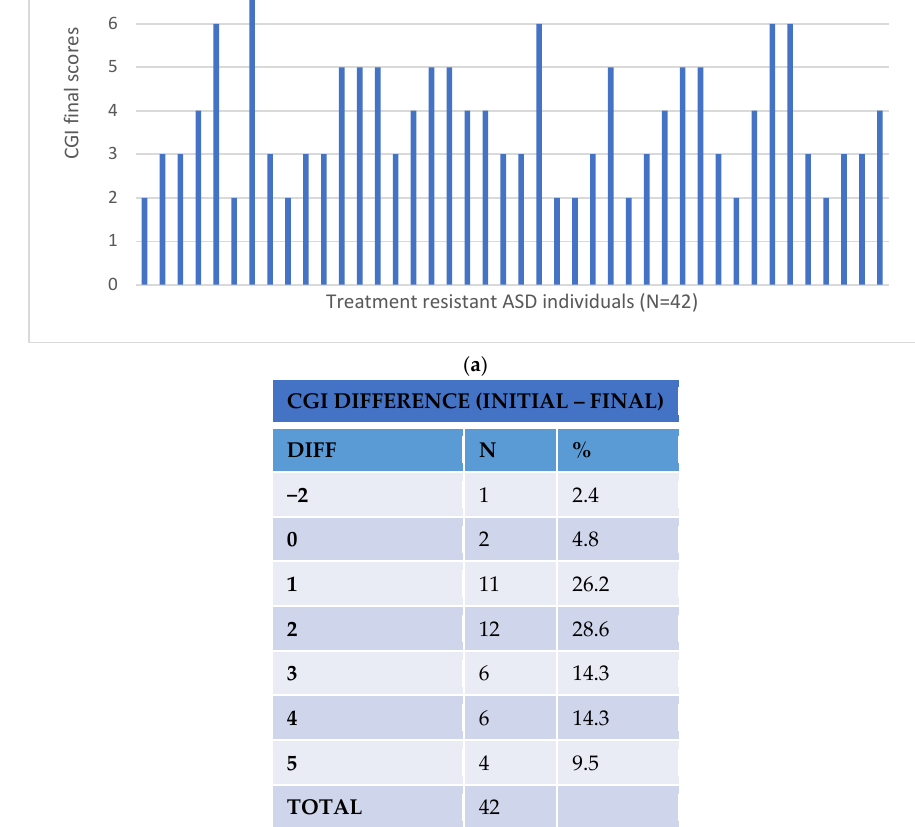
41 ( b ) Figure 2. CGAS results after pharmacogenetic intervention: ( a ) final CGI scores; ( b ) CGAS score difference (CGAS final – basal). 2.4. Statistical Analyses Linear regression analysis considering the difference in CGI or CGAS scores before and after treatment as the dependant variables, age and gender as covariates, and phar- macogenetic intervention (yes/no) as predictor variable were performed on the total co- hort (N = 104). The analysis model was repeated including patients with pharmacogenetic- guided treatment and control individuals that did not show response to explore the effect on the intervention on treatment-resistant patients. A final analysis including patients with pharmacogenetic interventions and control individuals who responded to their ini- tial treatment was also performed to further asses the efficacy of the intervention. All the